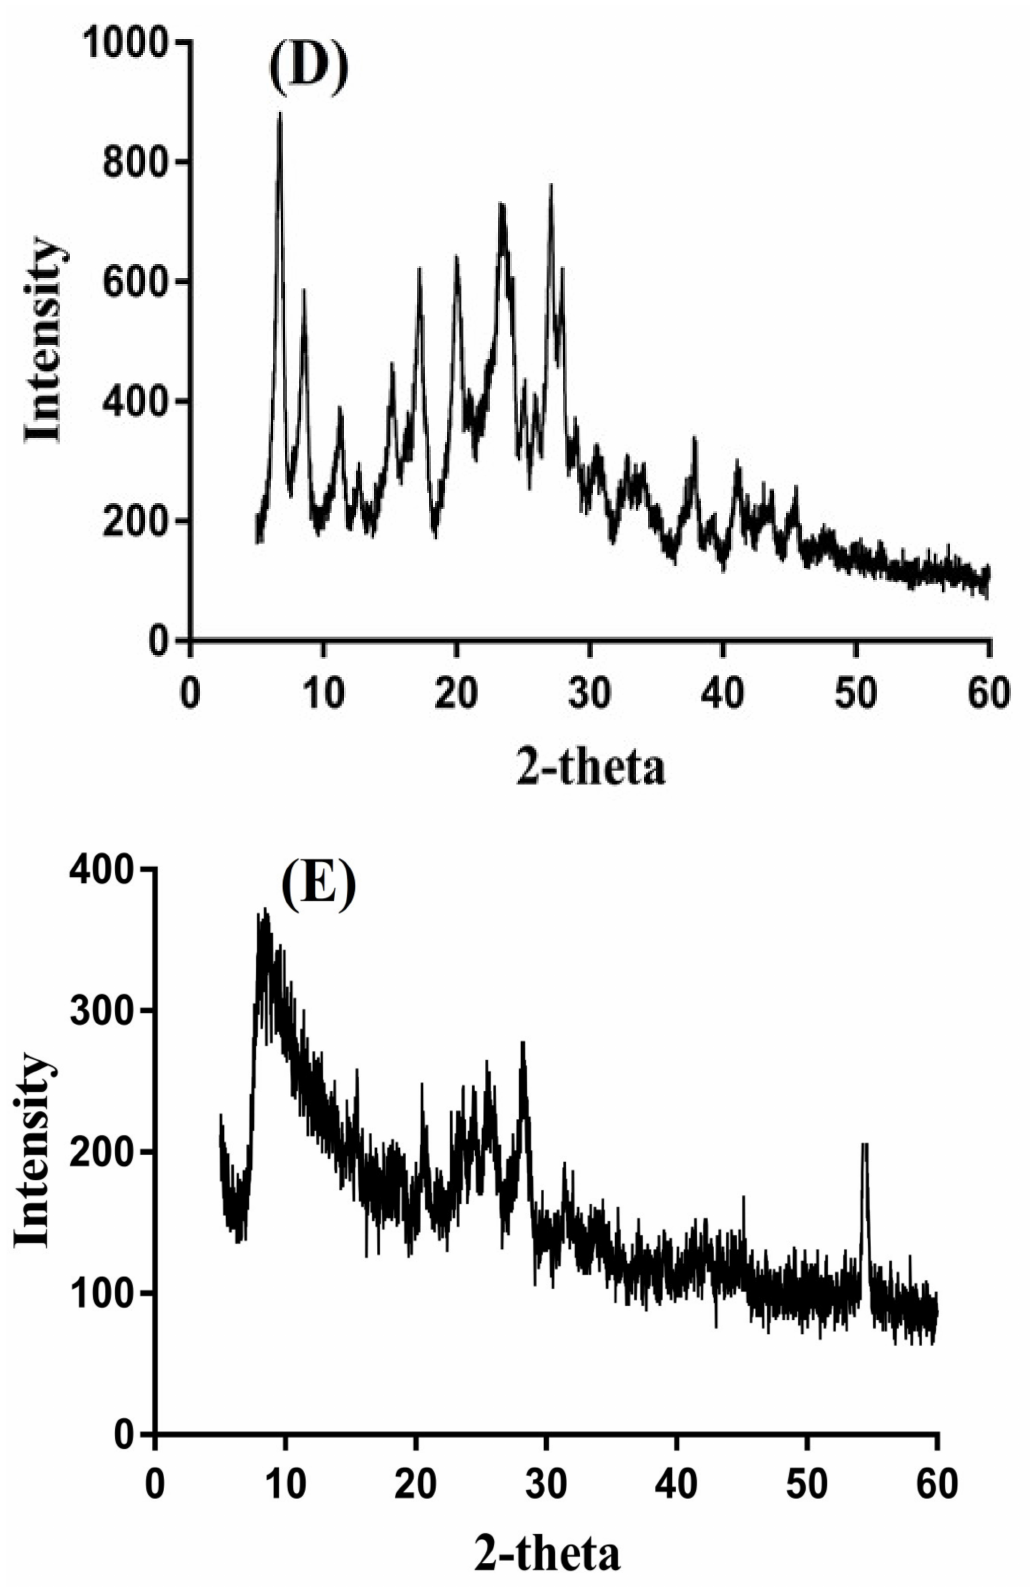
Figure 4. PXRD (Powder X-ray diffractometry) of ( A ) CS (Chondroitin sulfate), ( B ) CBP (Carbopol), ( C ) unloaded CS/CBP- co-PAA hydrogels, ( D ) DS (Diclofenac sodium), and ( E ) drug-loaded CS/CBP-co-PAA